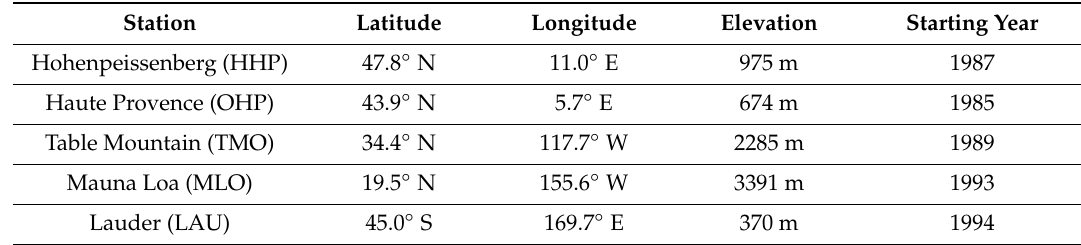
Table 1. Geographical data of stations with long-term ozone profile measurements from lidars analyzed in this study.